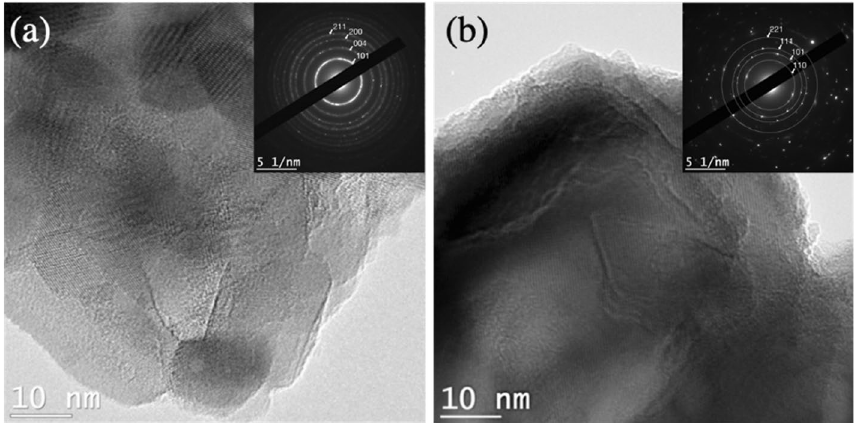
Figure 4. TEM images of red TiO 2 nanoparticles after laser-induced crystallization. ( a ) Red anatase-TiO 2 powder. ( b ) Red rutile-TiO 2 powder.